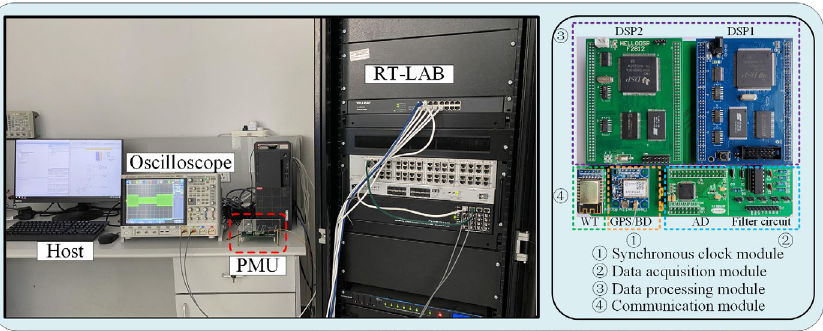
Figure 14. The experimental facilities ( left ) and PMU prototype hardware structure ( right ).